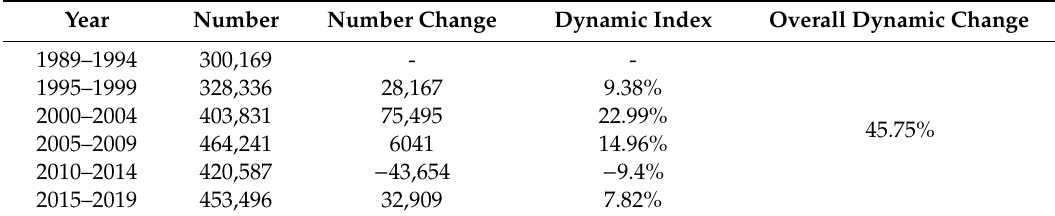
Table 2. The dynamic attitude of the maximum water body numbers from 1989 to 2019.